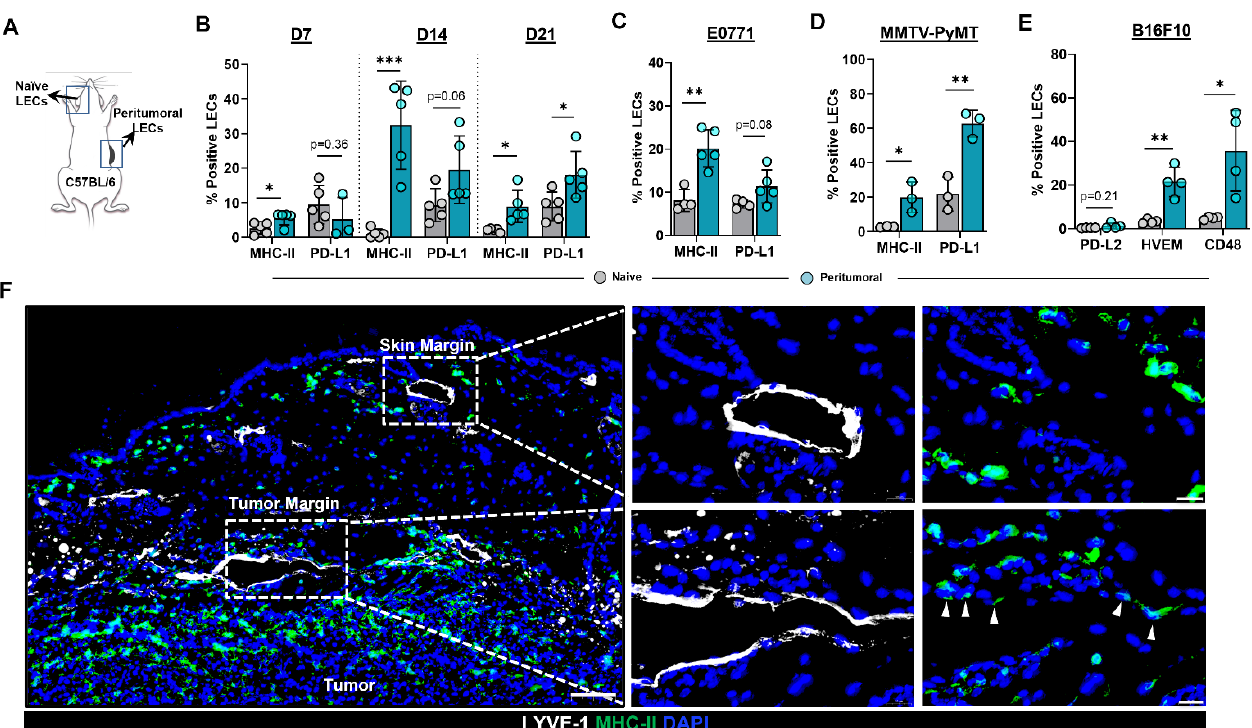
Figure 1. Peritumoral LECs upregulate MHC-II, PD-L1, and various co-inhibitory molecules compared to naïve dermal LECs. ( A ) Schematic of experimental design analyzing naïve dermal LECs in the ear and peritumoral LECs of the same mice. ( B ) Quantification of MHC-II and PD-L1 positivity in naïve and peritumoral LECs (CD45- podoplanin+ CD31+) at day 7, 14, and 21 post B16F10 tumor inoculation in WT (C57/BL6) mice. ( C ) Quantification of MHC-II and PD-L1 positivity in naïve and peritumoral LECs at day 14 post E0771 tumor inoculation in WT mice. ( D ) Quantification of MHC-II and PD-L1 positivity in naïve and peritumoral LECs in MMTV-PyMT mice with spontaneous mammary tumors. ( E ) Quantification of PD-L2, HVEM, and CD48 positivity in naïve and peritumoral LECs at day 21 post B16F10 tumor inoculation in WT mice. ( F ) Representative immunofluorescence image stained for LYVE-1 (white) and MHC-II (green) in peritumoral and skin margin lymphatics in WT mice at day 14 post B16F10 inoculation. DAPI nuclear staining in blue. Scale bars, 100 µ m ( left ), 20 µ m ( top right and bottom right ). Statistical significance assessed using paired student’s t test on data from at least 3 biological replicates; error represented as SD. *, p < 0.05; **, p < 0.01; ***, p <